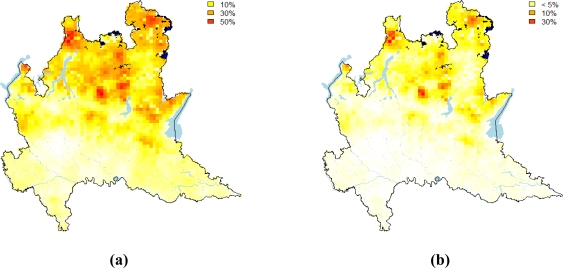
(a) Probability maps for the reference values of 200 Bq/m3. (b) Probability maps for 400 Bq/m3.